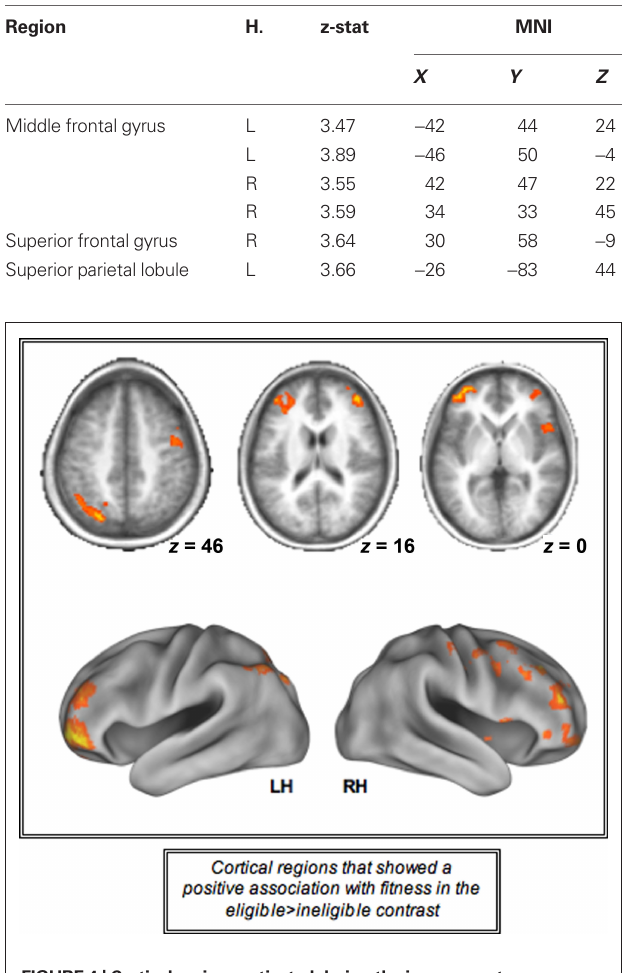
Table 3 | local maxima of cortical regions identified during the incongruent-eligible > incongruent-ineligible contrast that showed a positive association with cardiorespiratory